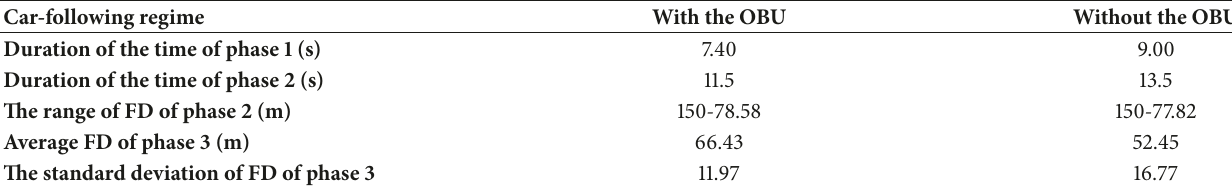
Table 4: Distribution of vehicle and drivers operating